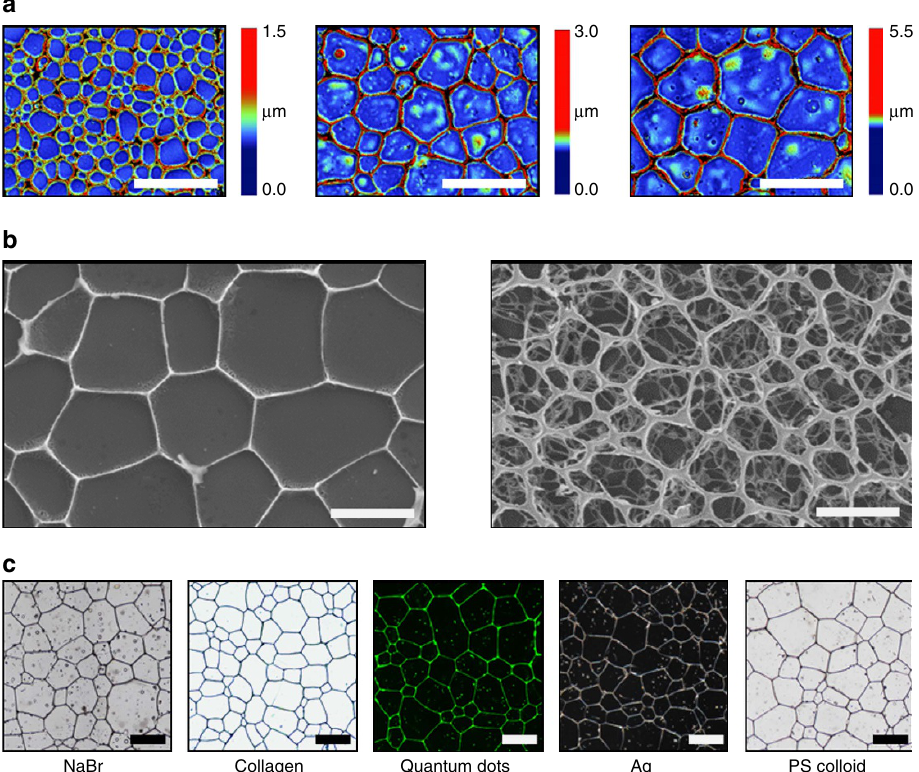
Figure 5 | Porous materials prepared using recrystallized ice crystals as template. The images in ( a ) show that the size of the 2D meshes can be easily regulated by changing the ions or the ion concentration in the initial aqueous solution. ( b ) The 2D and 3D porous materials can be prepared with recrystallized ice crystals as the template. ( c ) Various materials such inorganic salts, collagen, quantum dots, metallic nanoparticles and polystyrene colloids can be used to prepare porous materials. All the scale bars are 200 m